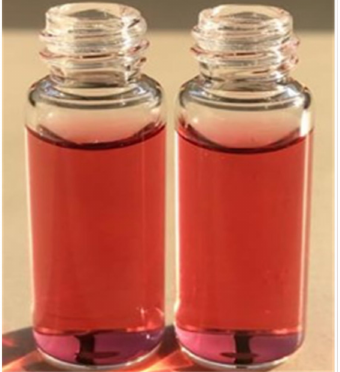
Figure 1. A representative image of the prepared nanoparticles (NPs), in which the dark red wine color indicated the successful preparation of sialic acid conjugated Au NPs (SA-Au NPs).